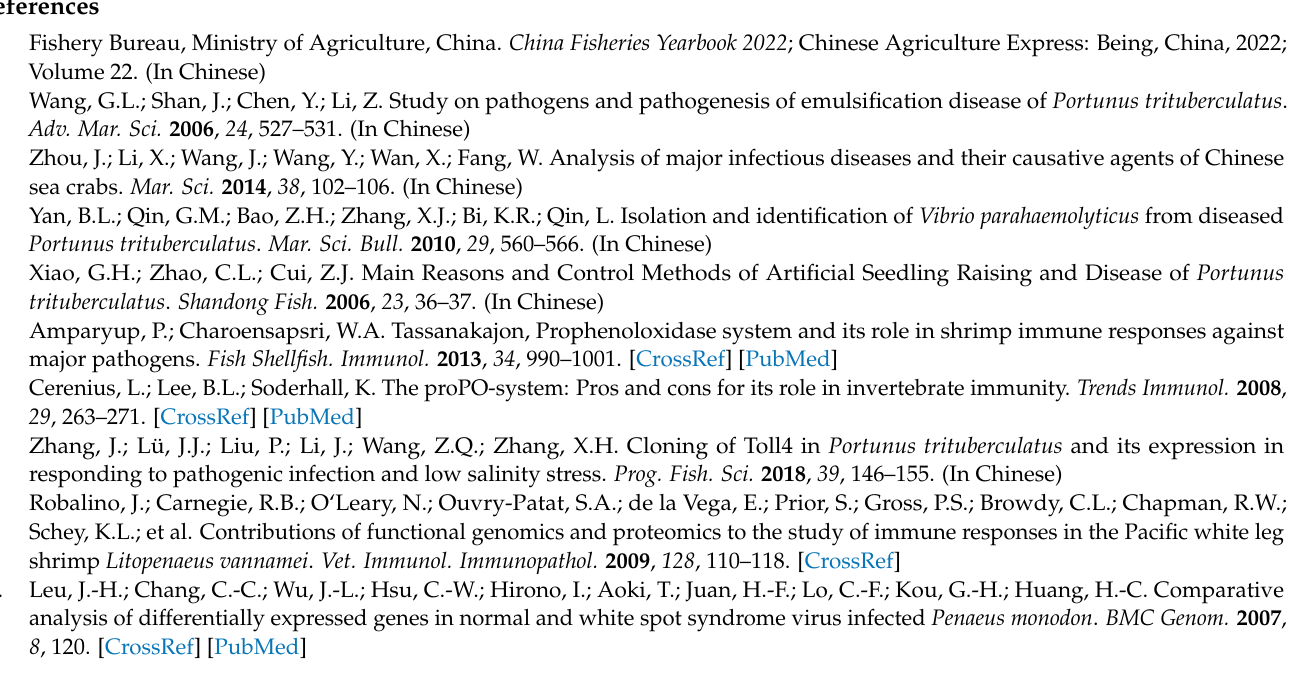
Table S5: In the enrichment analysis of GO for the DEPs between the experiment and control group after the V. parahemolyticus